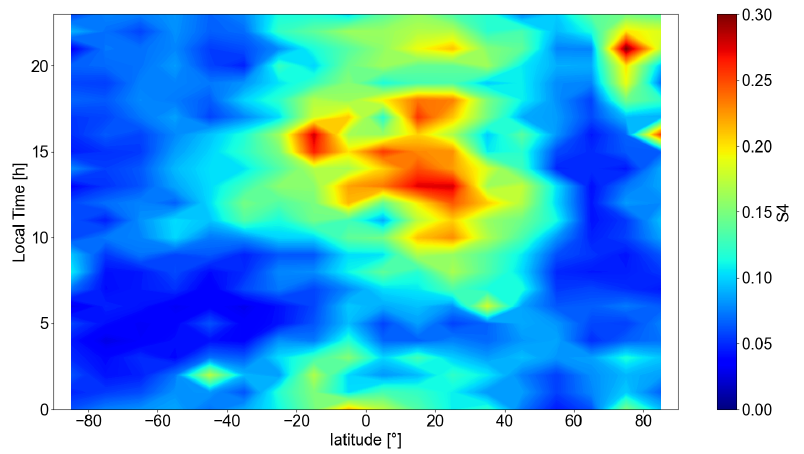
Figure 7. The S4 scintillation index in the latitude range of 80° to 80° south and north in September